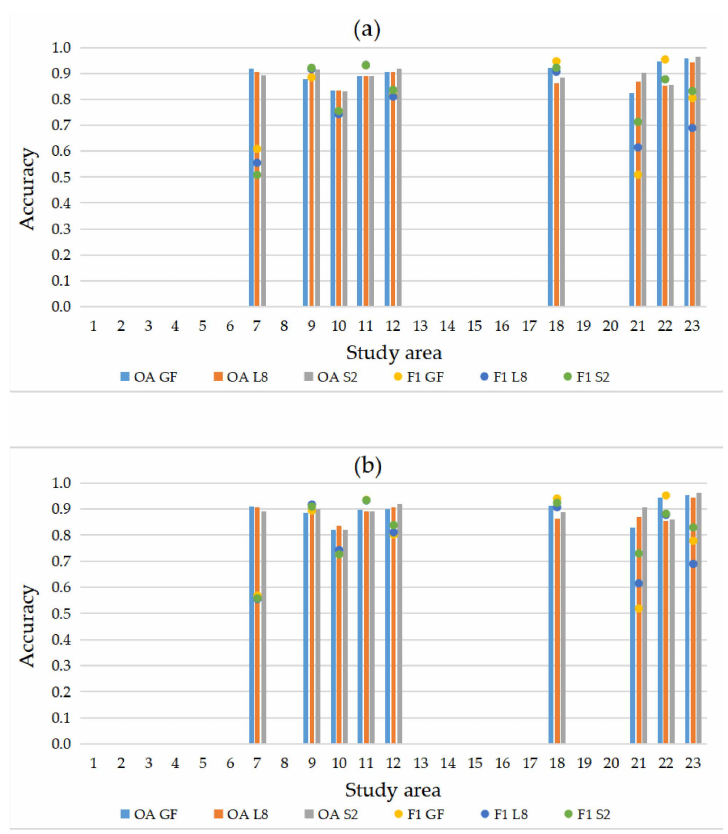
Figure 7. The accuracy of GF-1 WFV, L8, and S2. ( a , b ) show the accuracy comparison at OSR and 30 m resolutions, respectively.